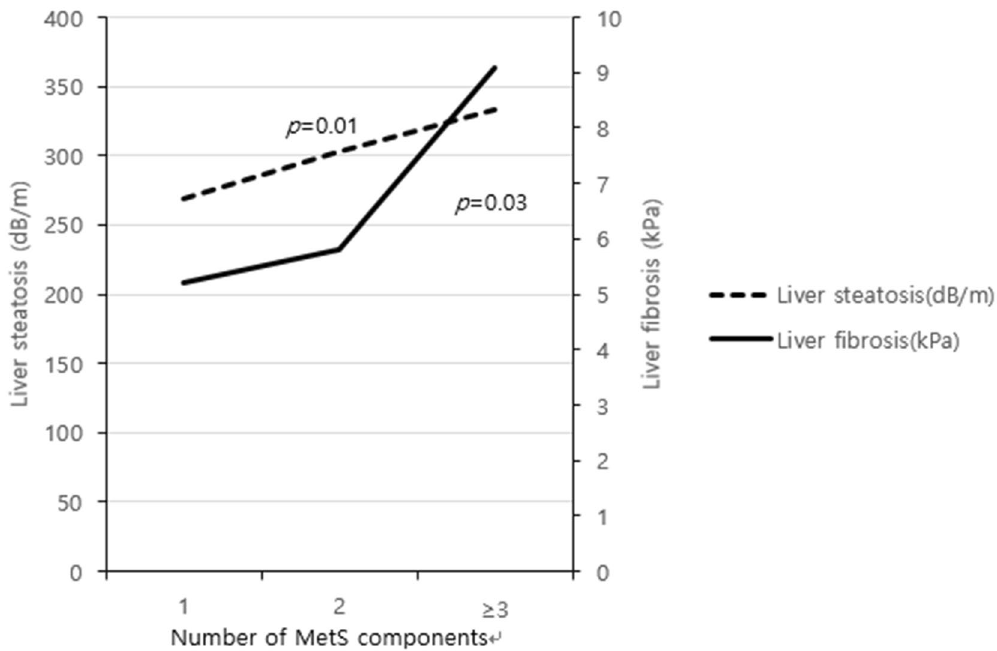
Figure 3. Number of metabolic syndrome components at the time of polycystic ovary syndrome diagnosis and liver fibroscan profiles in Korean